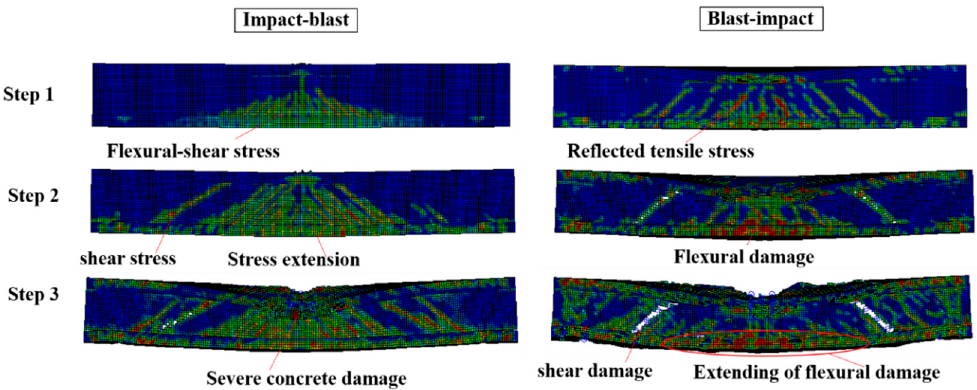
Figure 6. Numerical analysis results of damage behavior of I-shaped RC beams under different impact rates and proportional distances.